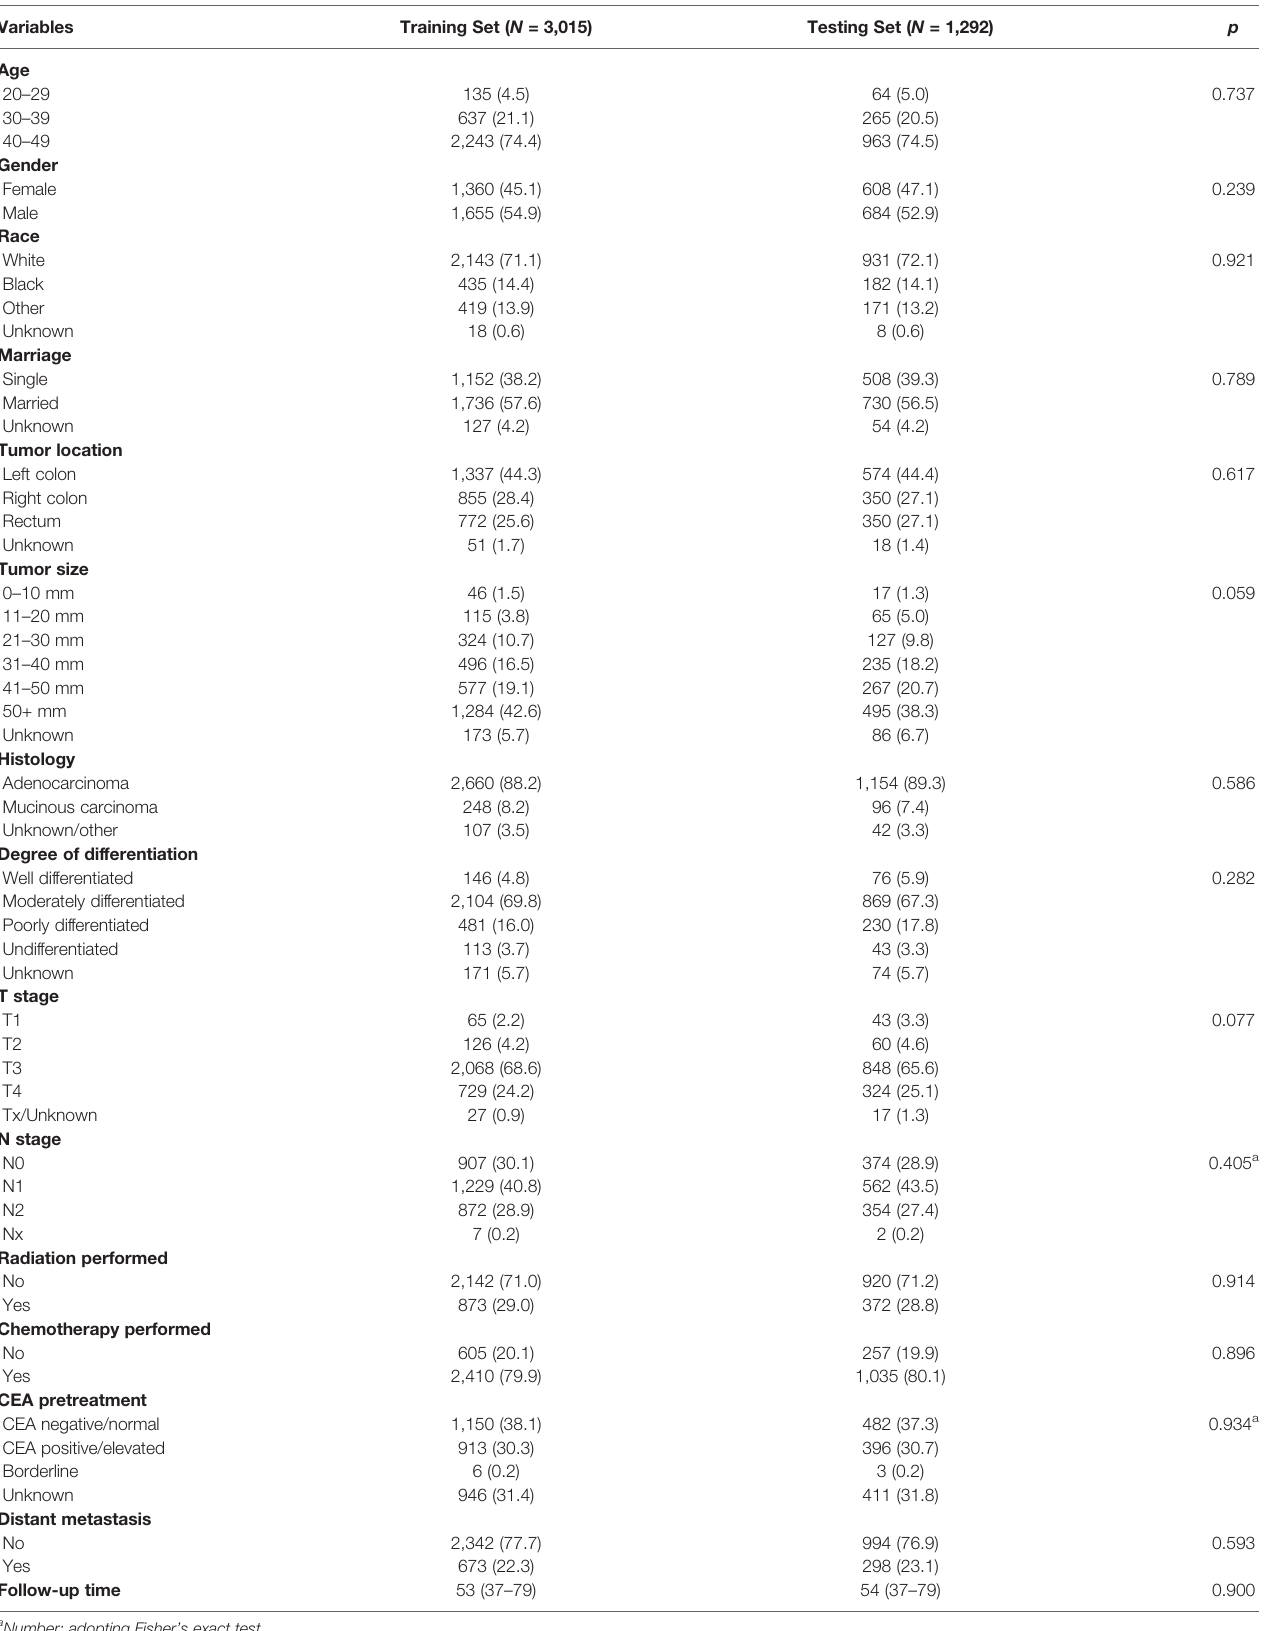
TABLE 3 | Clinicopathological characteristics of young-onset colorectal cancer in training set and testing set in advanced stage